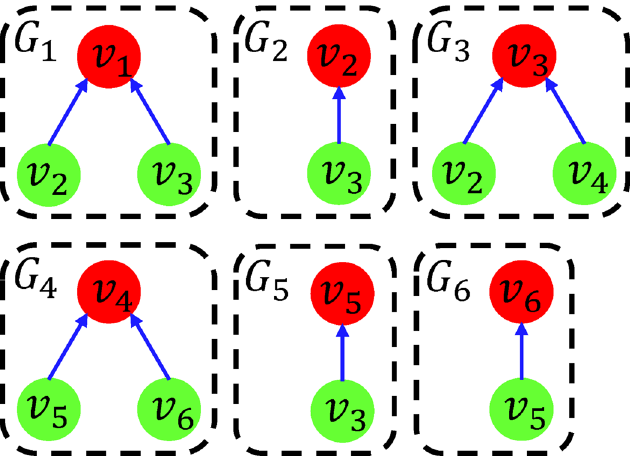
Fig 3. The MEB-based network partition. For the network G in Fig 2A, the MEB-based network partition consists of six blocks each of which has a single node (depicted as a red node). Each subnetwork G i is constructed based on each block. Input nodes are depicted as green